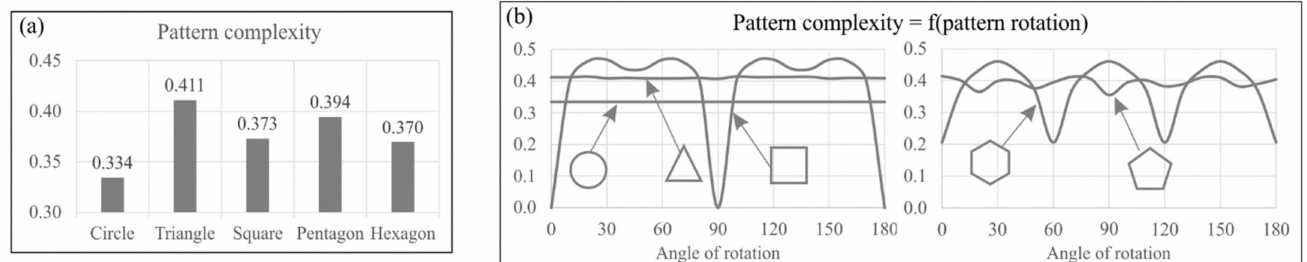
Figure 10. Morphological characteristics of regular geometrical shapes. ( a ) Pattern complexity of the five simplest geometrical figures. ( b ) Pattern complexity of the five simplest geometrical figures as the function of their